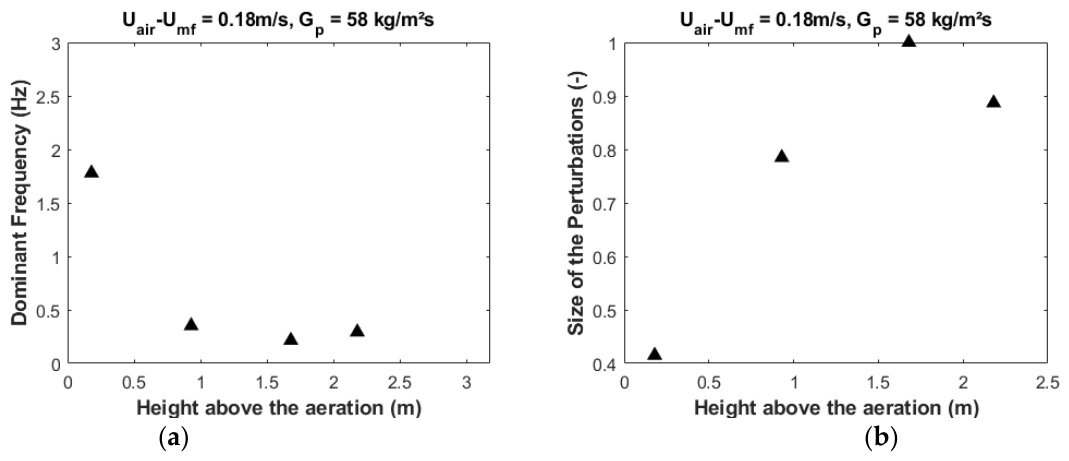
Figure 10. Evolutions with the height of ( a ) the dominant frequency of the IOP spectrum and ( b ) the integral of the IOP spectrum, for the same experimental configuration as for Figure 9.